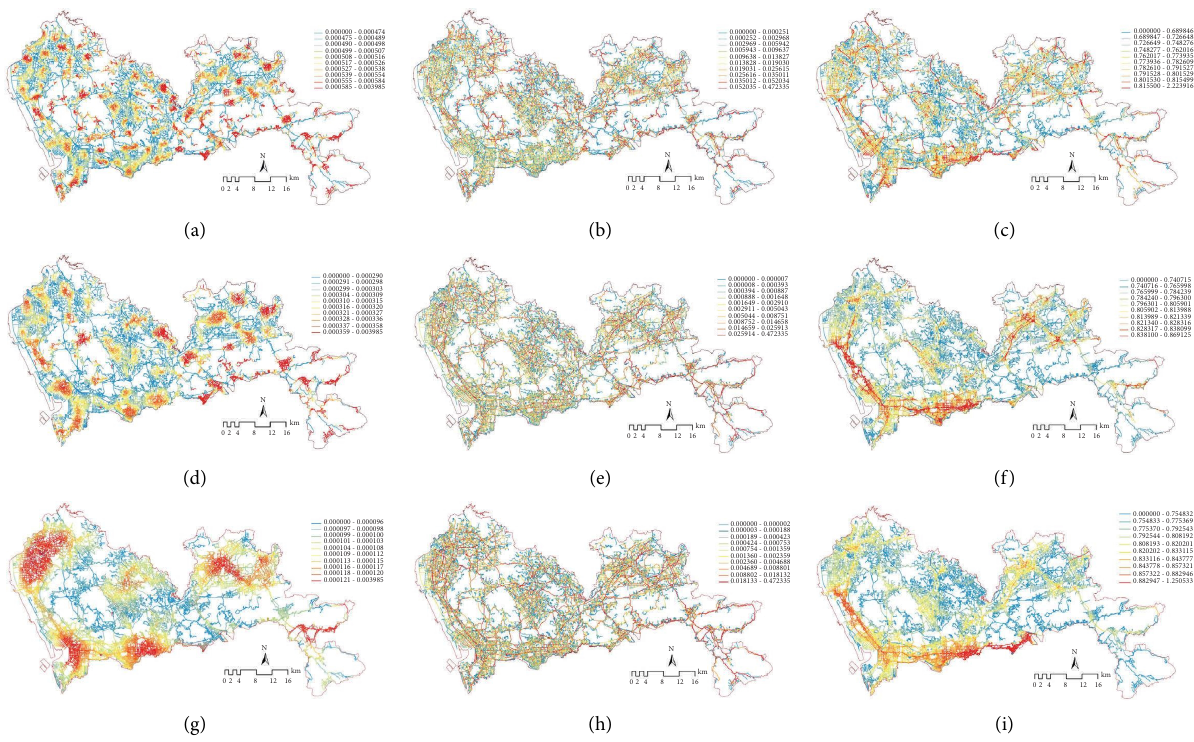
Figure 12: Spatial distribution of Shenzhen’s local roads centrality. (a) Closeness centrality (3km). (b) Betweenness centrality (3km). (c) Straightness centrality (3km). (d) Closeness centrality (8km). (e) Betweenness centrality (8km). (f) Straightness centrality (8km). (g) Closeness centrality (15km). (h) Betweenness centrality (15km). (i) Straightness centrality (15